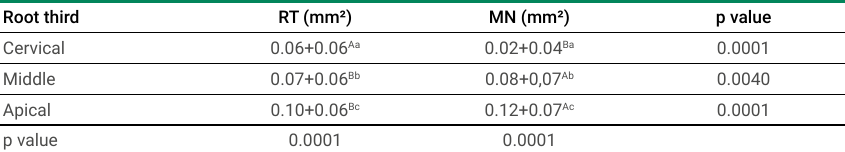
Table 3. Mean (±SD) area (mm 2 ) of remaining filling material in the root thirds according to the experimental groups Root third